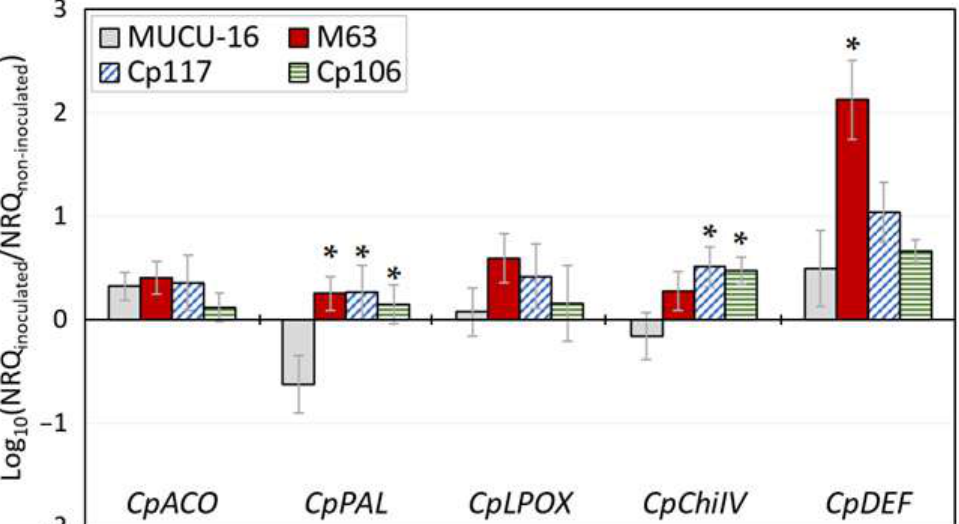
Figure 4. Differential gene expression between genotypes in inoculated and non-inoculated samples Phytopthora capsici for each genotype. Each bar represents the genotype (MUCU-16, M63, Cp117, or Cp106) mean of the normalized relative quantity transformations between the inoculated and non-inoculated samples (LOG 10 [NRQ inoculated /NRQ non-inoculated ]) from pooled samples of root and crown tissues and the days 3, 10 and 14 post-inoculation. Positive values are up-regulation and negative are down-regulation for the inoculated samples. Significant differences (*) from the MUCU-16 control were determined with Student’s t -test ( p < 0.05, number of samples compared = 12). Error bars represent the standard errors ( n = 6).